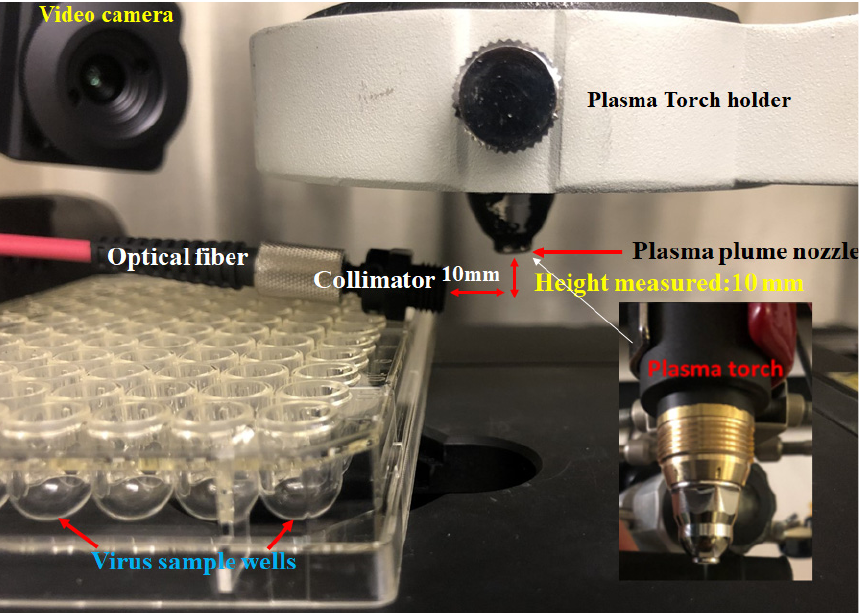
Figure 2. Photograph showing the experimental setup for the optical emission spectroscopy (OES)